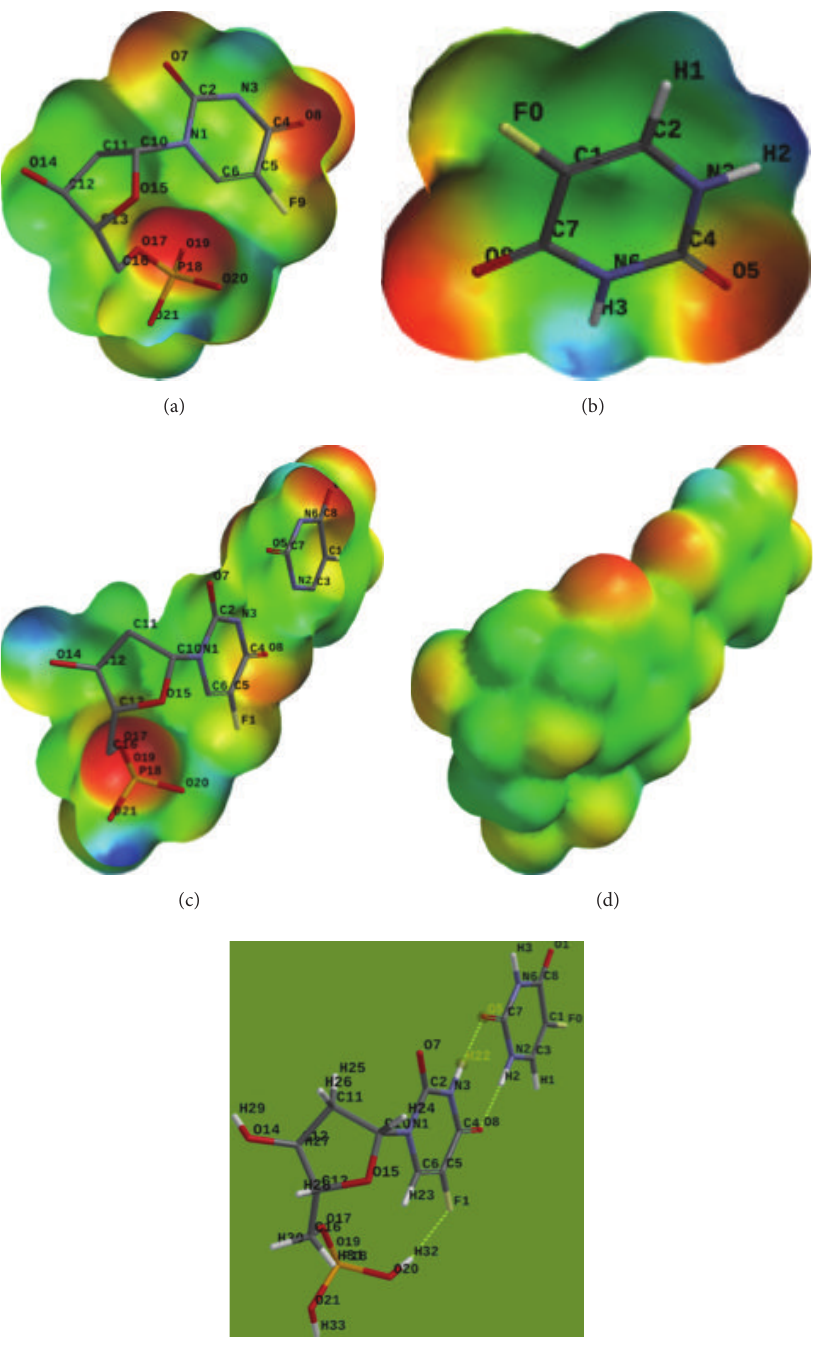
Figure 6: ESP map of FdUMP (a), 5-FU (b), the adduct of (a) and (b) (c), the full ESP map of the adduct (d), and the formed two H-bonds between (a) and (b)